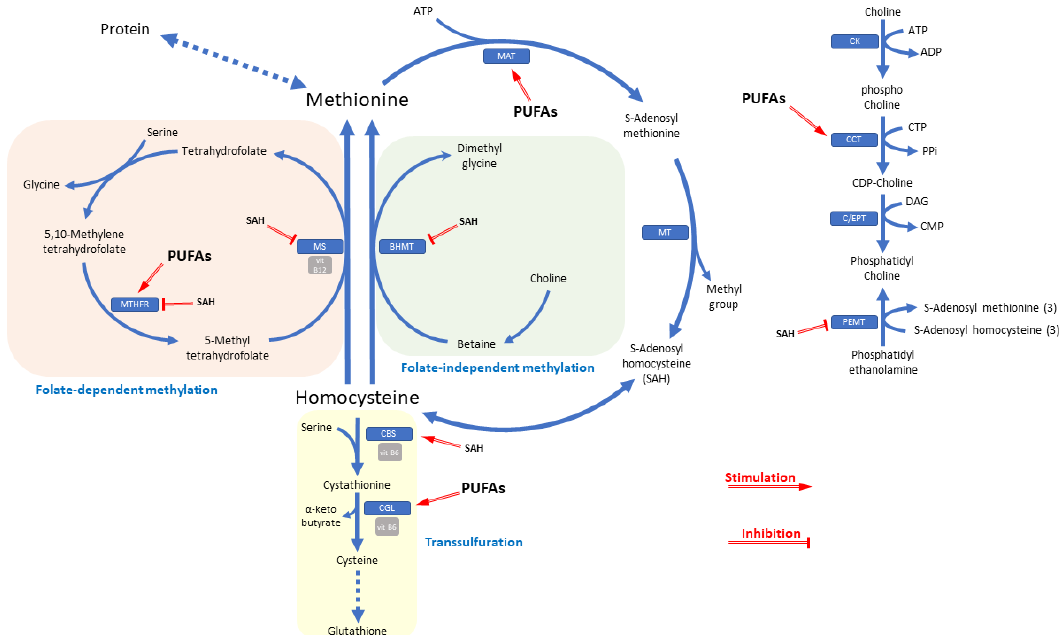
Figure 1. Metabolism of homocysteine and regulation. BHMT: Betaine homocysteine methyltransferase; C / EPT: Choline / ethanolamine phosphotransferase; CBS: Cystathionine- β -synthase; CCT: CTP: choline-phosphatase cytidylyltransferase; CGL: Cystathionine- γ -lyase; CK: Choline Kinase;